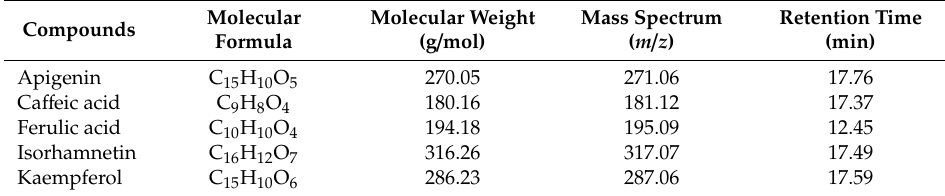
Table 2. Liquid chromatography-mass spectrophotometry analysis of bee bread.